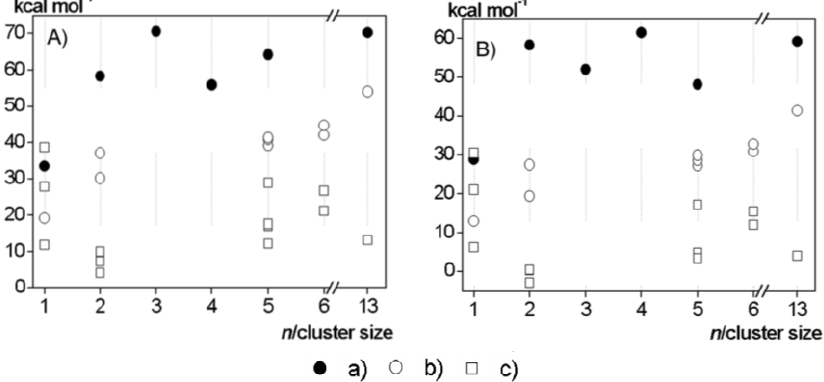
Figure 3. Dependence on n of (a) addition energy of a single Pd atom to the Pd binding energy of [BF energy; ( B ) Gibbs-free energy. Reprinted from Ref. [31], with permission from